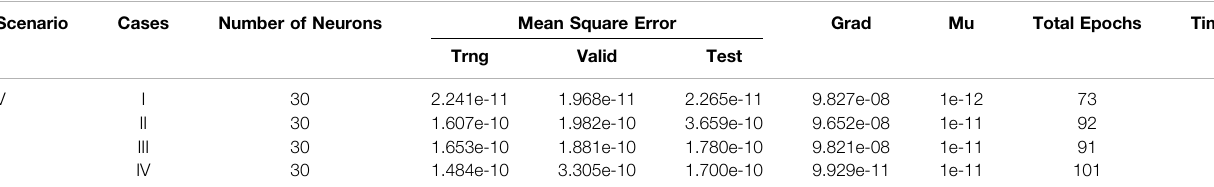
TABLE 8 | Numerical performance indicators for scenario V. Scenario Cases